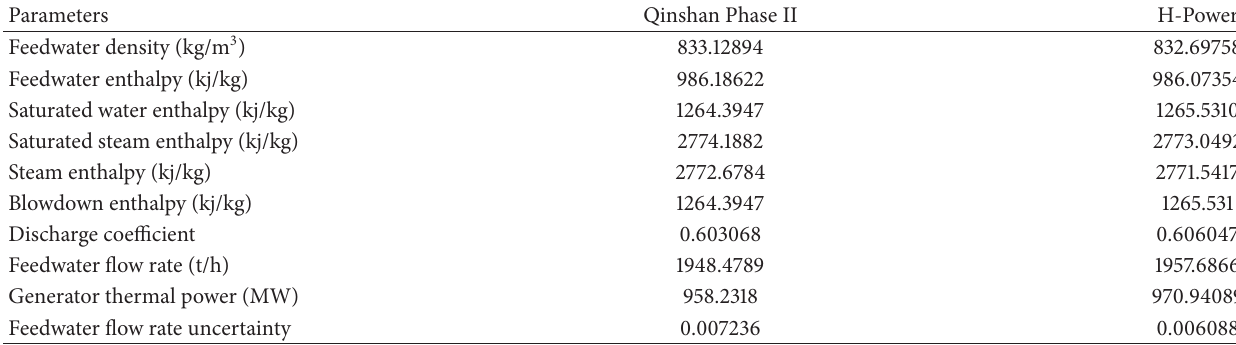
Table 5: Comparison between the results of the values of Qinshan Phase II and